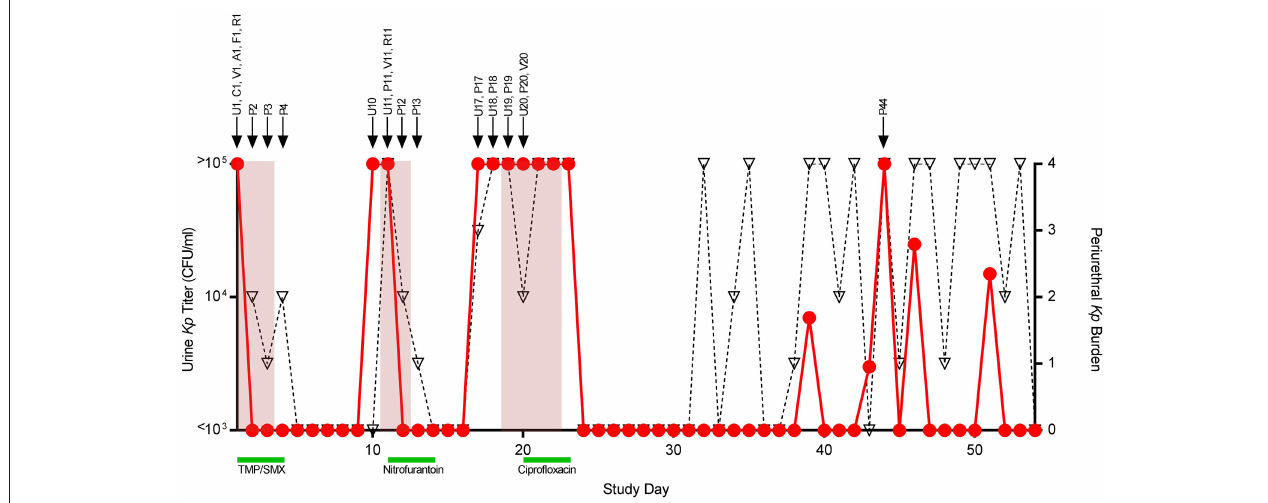
FIGURE 1 | Patient course and isolates collected. Daily urine culture titers of Klebsiella pneumoniae ( Kp ) are shown quantified on the left y-axis (circles, red line). Daily periurethral swab titers are semi-quantitated on the right y-axis (triangles, dotted black line) with quadrant 4 indicating the highest relative burden of bacteria. Days the patient experienced urinary symptomatology are shaded in red. Antibiotic treatment courses are denoted by green bars. Arrows above the graph signify the collection date of individual strains denoted by a letter indicating collection site followed by a number indicating study day collected. Abbreviations, U, urine